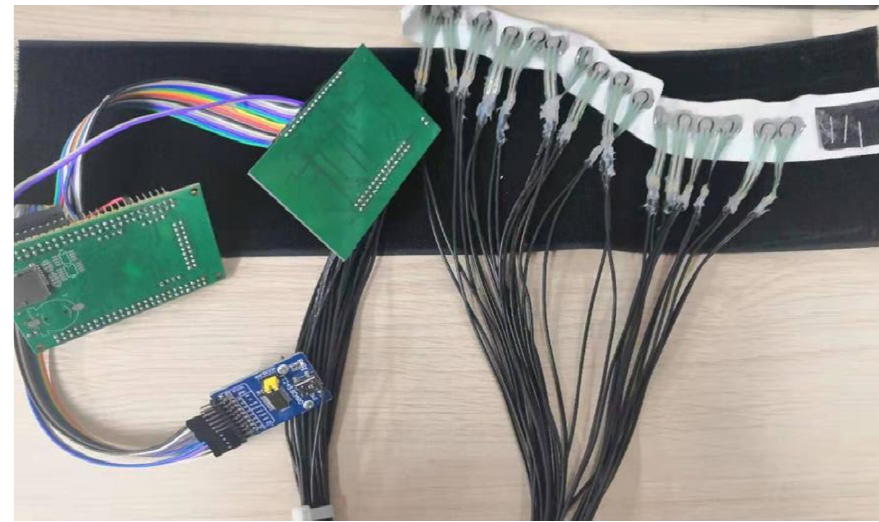
Figure 2. The hardware prototype for FMG acquisition.